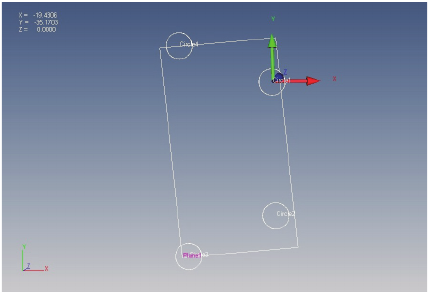
Figure 4: Establishment of coordinate system for measurements.